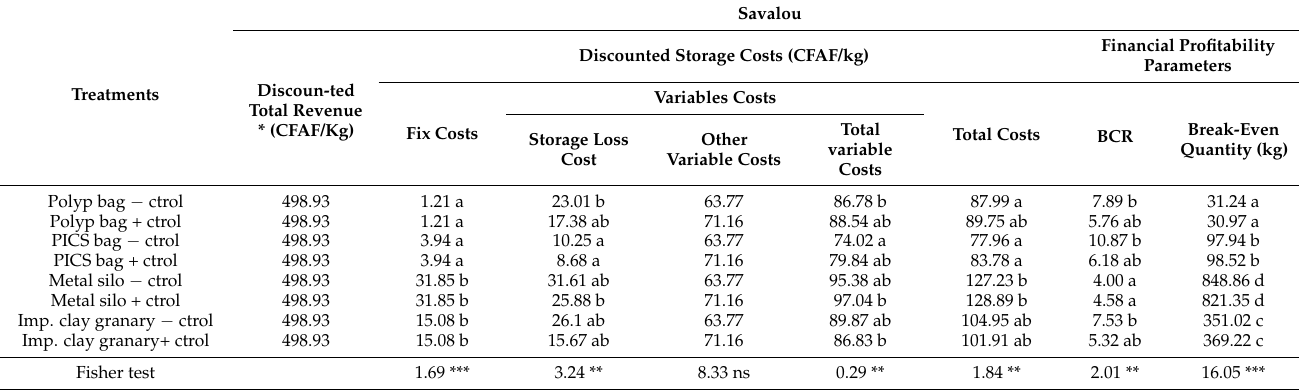
Table 3. Benefit–cost ratio and break-even quantity of the different treatments implemented in Savalou.